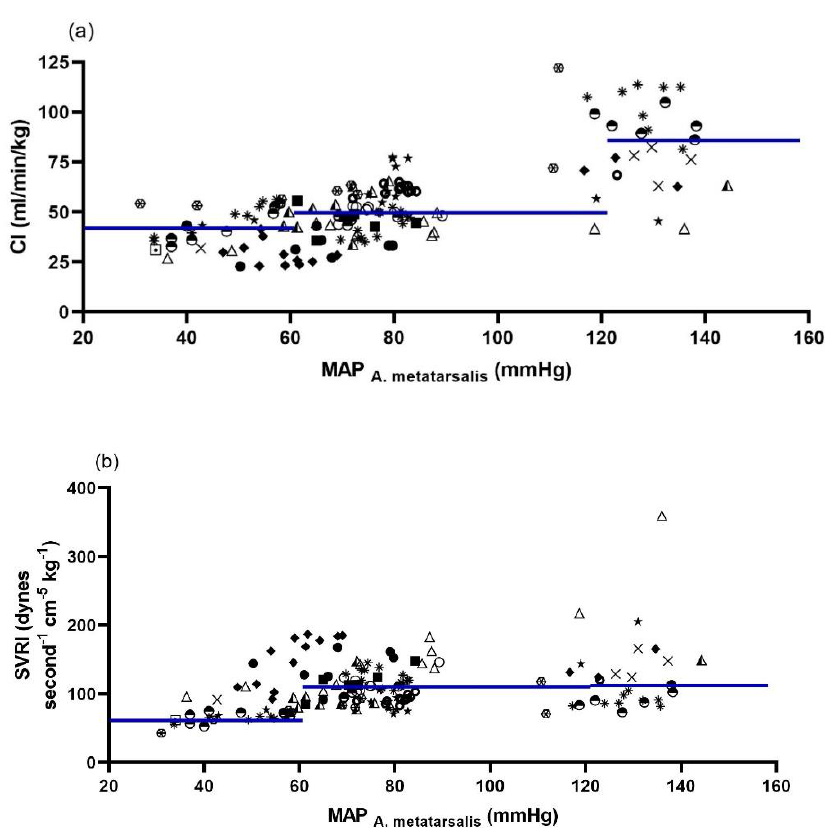
Figure 4. Plots depicting calculated cardiac index (CI) ( a ) and systemic vascular resistance index (SVRI) ( b ) in relation to invasively measured blood pressure (IBP) obtained at the metatarsal artery (MA) in 11 isoflurane anaesthetised and dorsally recumbent horses at different blood pressure ranges (normotension: MAP 61–119 mmHg; hypotension: MAP ≤ 60 mmHg; hypertension: MAP ≥ 120 mmHg). Each symbol represents measurements obtained from one horse. The solid blue horizontal lines represent mean CI and SVRI (n = 11 horses) for each blood pressure range, respectively. MAP = mean arterial pressure.